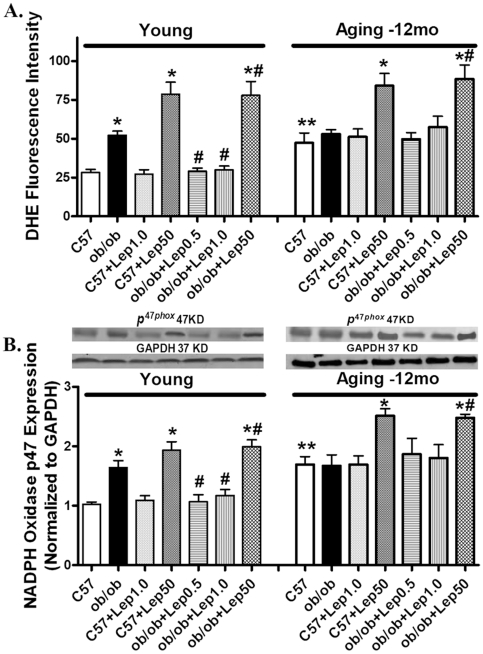
O2
− production (Panel A) and
p
47
phox
 NADPH oxidase subunit expression (Panel B) measured by DHE
fluorescence and immunoblotting, respectively, in cardiomyocytes
freshly isolated from young (4-month-old) or aging (12-month-old)
lean (C57) and
ob/ob
 mice treated with or without leptin (0.5, 1.0 and 50 nM)
for 4 hrs.
Insets: Representative gel blots of
p
47phox NADPH oxidase
subunit using specific
anti-p
47phox
antibody. GAPDH was used as the loading control. Mean ± SEM,
n = 12–14 (Panel A) and
9–11 (Panel B) per group, * p<0.05
vs. respective C57 group, **
p<0.05 vs. young C57 group, # p<0.05
vs. respective ob/ob group.